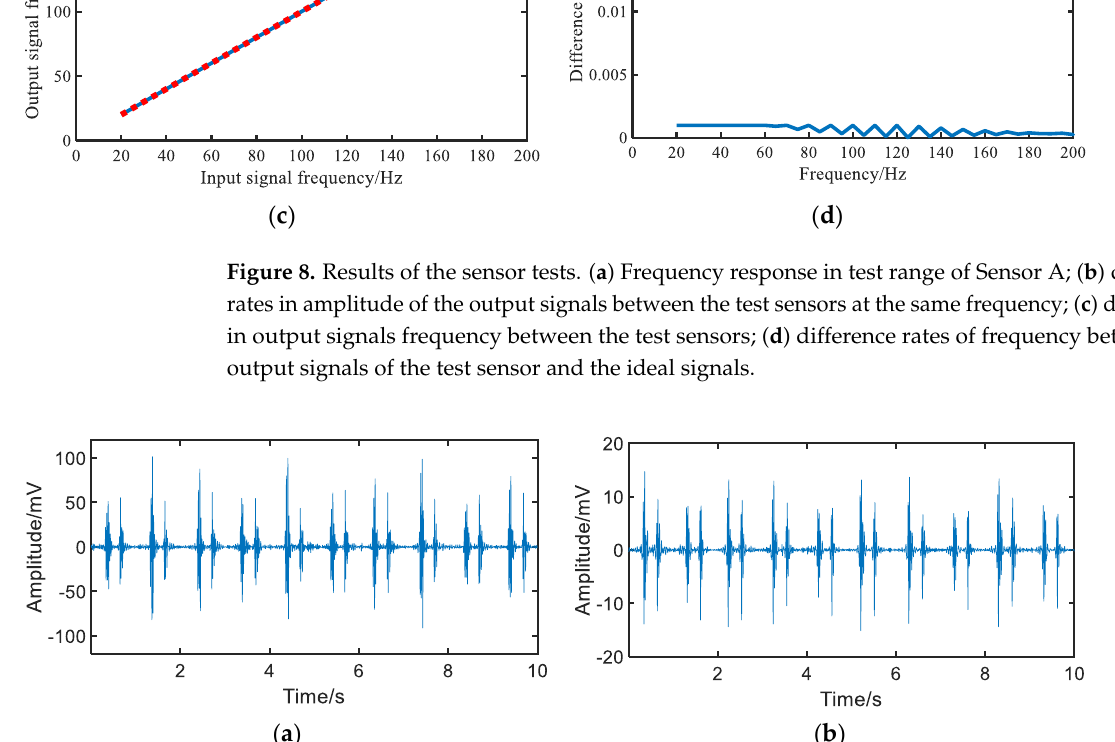
differences in output signals frequency between the test sensors; ( d ) difference rates of frequency between the output signals of the test sensor and the ideal signals.